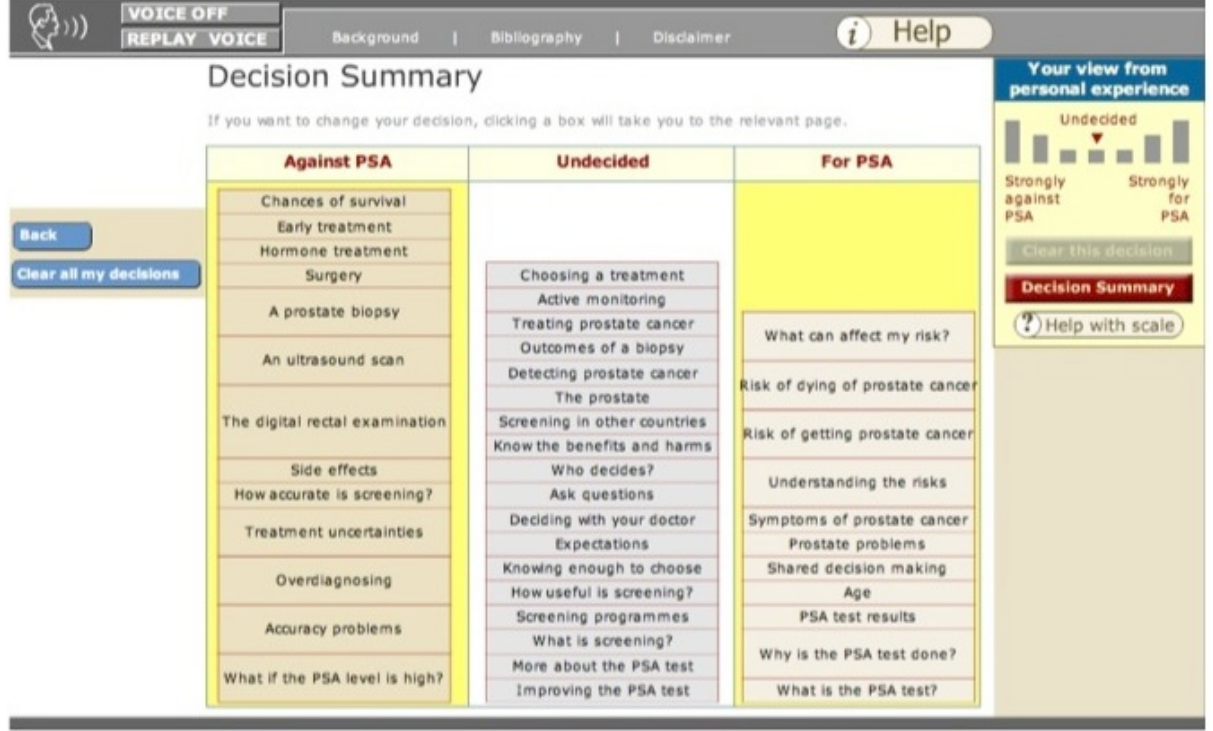
Figure 3. A screenshot of the decision summary in